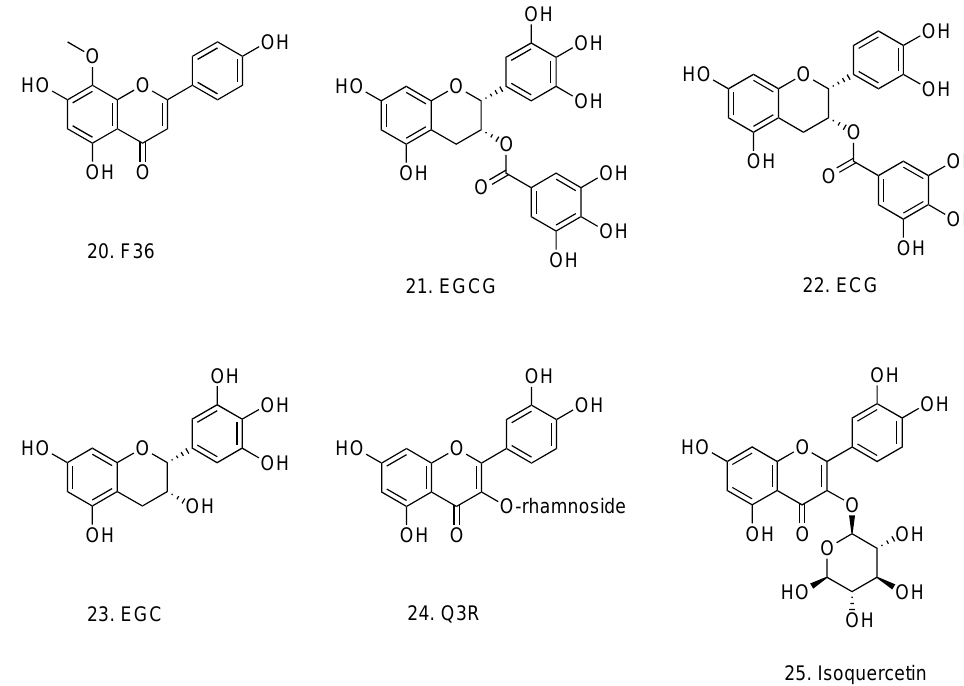
Figure 5. Flavonoids with anti-influenza virus